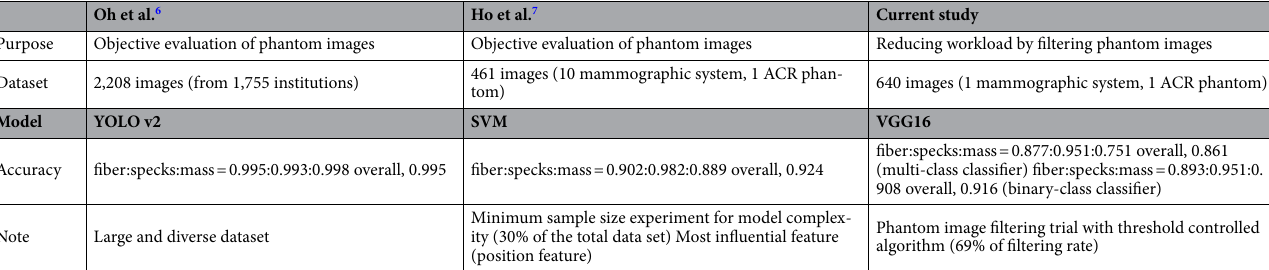
Table 1. Comparison with the previous ACR phantom studies. ACR, American College of Radiology; YOLO v2, You Only Look Once version 2; SVM, Support Vector Machine; VGG16, Visual Geometry Group 16.